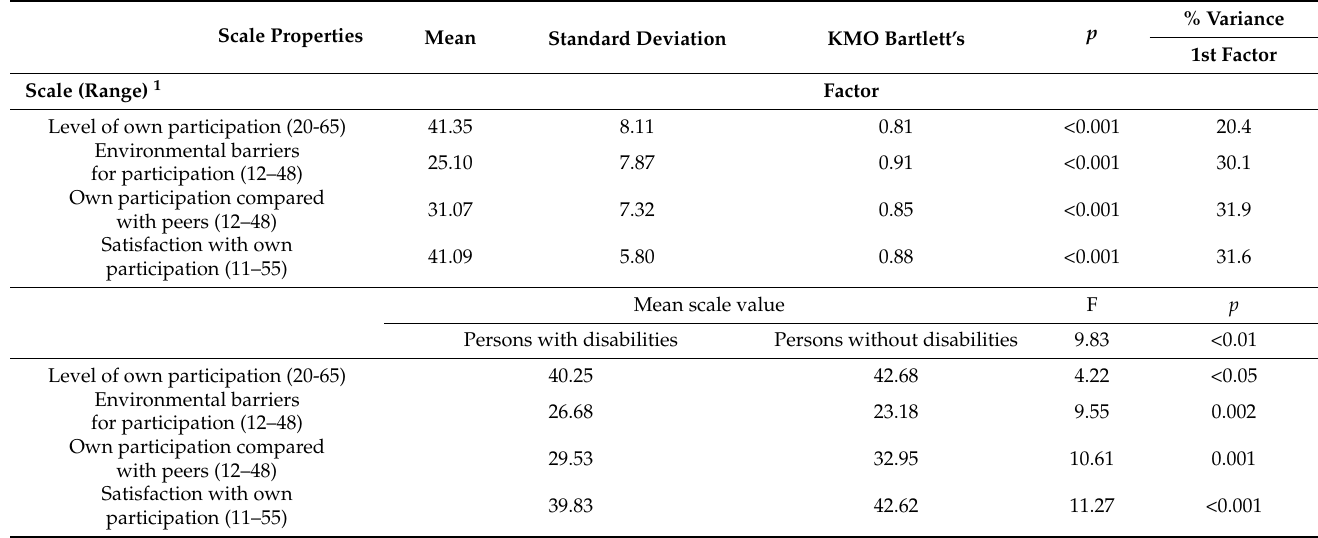
Table 4. Scale properties and level of participation among persons with and without disabilities ( n =